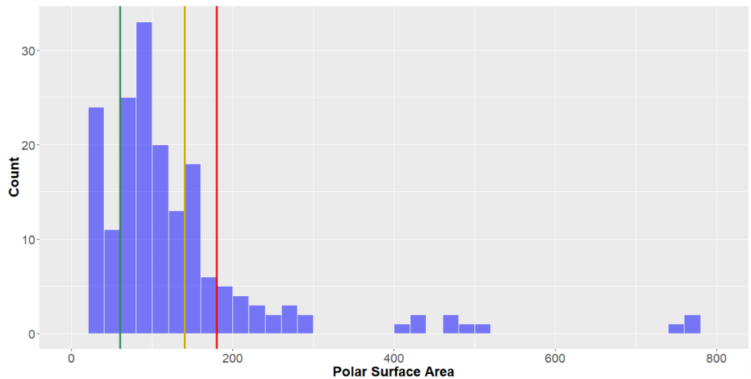
Figure 10. The statistical distribution of the polar surface area (PSA) of all analysed compounds (green = 60, compounds < 60 Å 2 are in the lead-like space; yellow = 140, compounds < 140 Å 2 are in the drug-like space; red = 180, compounds < 180 Å 2 are in the KDS. Total number of compounds =